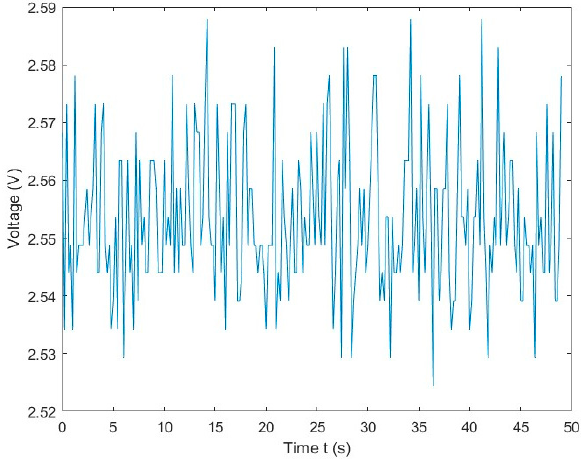
Figure 15. Voltage variation detected with the ACS712-05 sensor for I = 0 A.